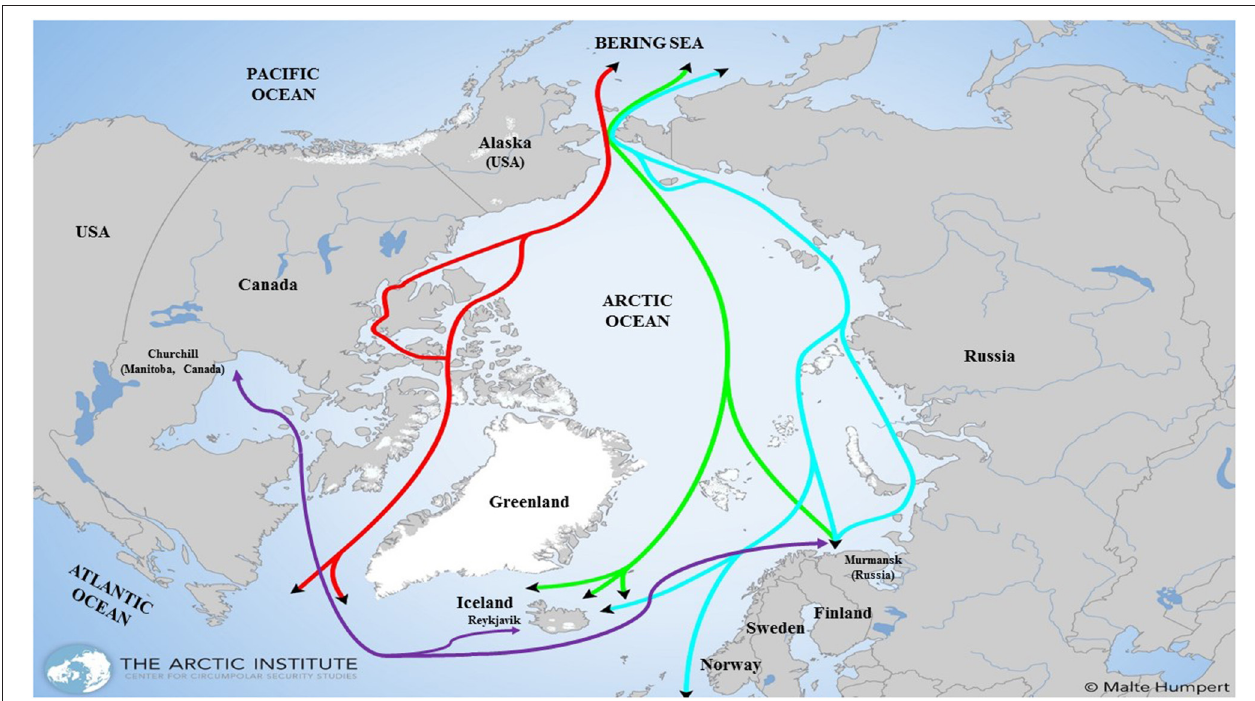
FIGURE 1 | Various arctic shipping routes that are opening up due to the reduction of Arctic Ocean ice coverage. Original image provided by Malte Humpert/THE ARCTIC INSTITUTE, Center for Circumpolar Security Studies (used with permission). Image was modified by adding labels and the purple arrow line. Red: Northwest Passage; Turquois: Northern Sea Route; Green: Transpolar Sea Route; Purple: Arctic Bridge